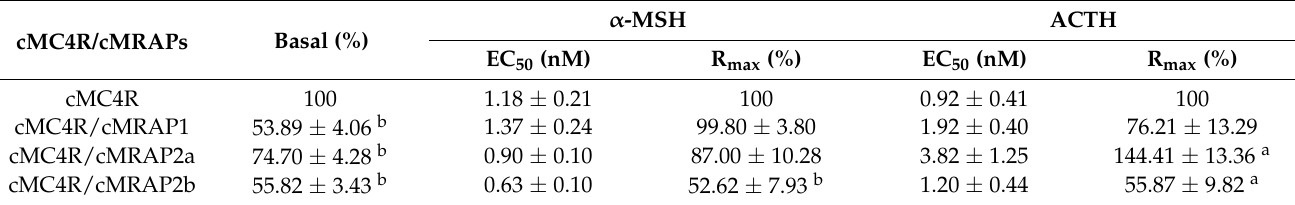
Table 6. The effect of MRAPs on signaling properties of